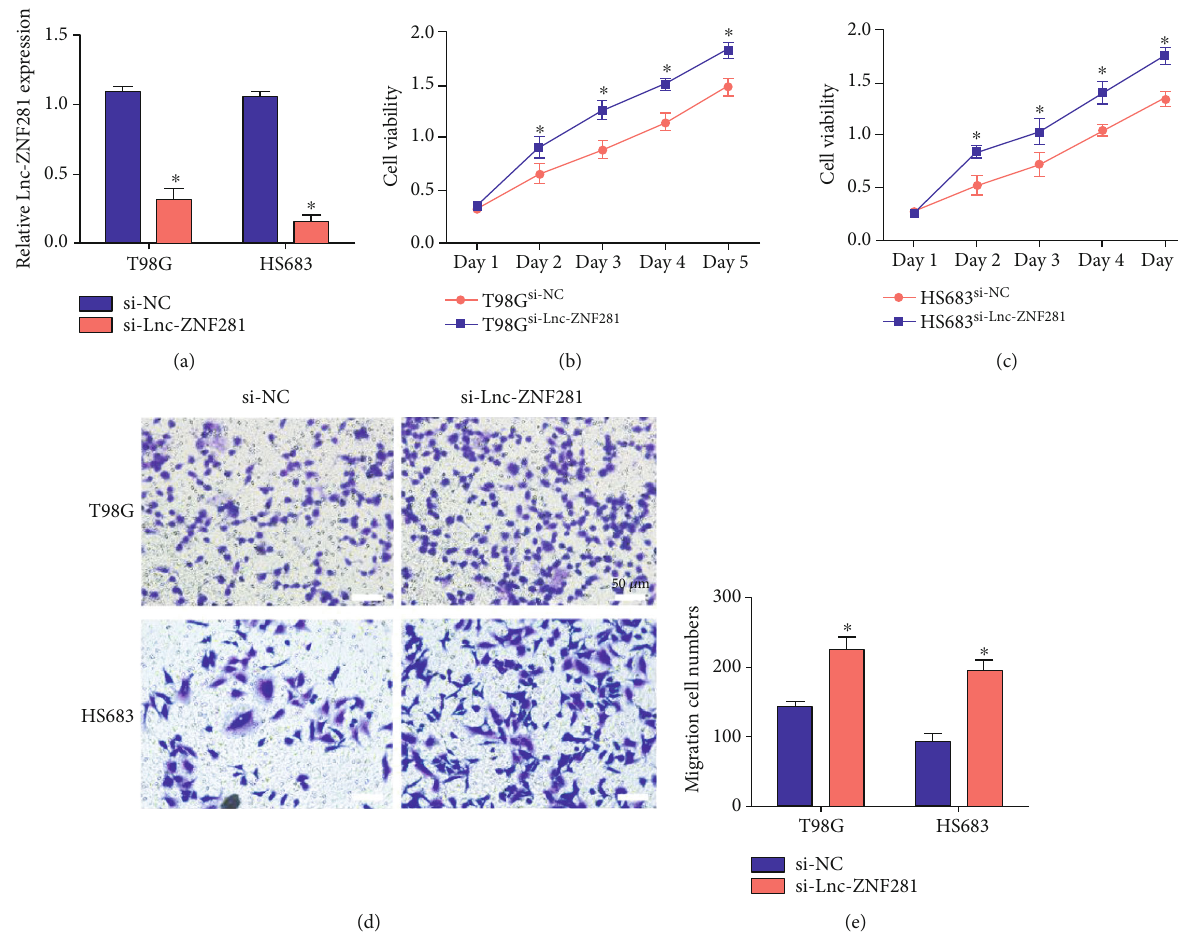
Figure 4: Inhibition of lnc-ZNF281 inhibited glioma cell proliferation and migration. (a) qRT-PCR results indicated that the expression level of lnc-ZNF281 in glioma cells decreased signi fi cantly after si-lnc-ZNF281 transfection. (b, c) The CCK-8 assay results indicated that inhibition of lnc-ZNF281 promoted the proliferation of glioma cells. (d, e) The transwell assay results indicated that overexpression of lnc- ZNF281 inhibited cell migration in glioma. Scale bars = 50 μ m. ∗ p < 0 : 05